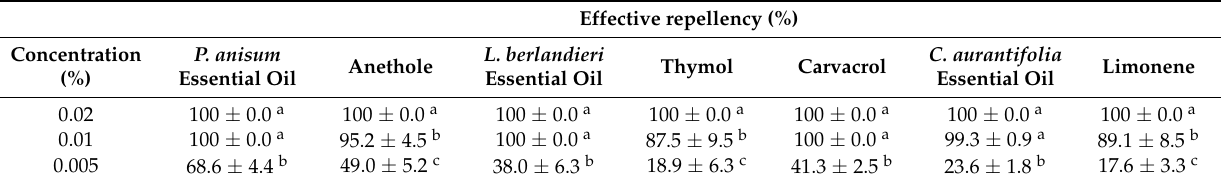
Table 5. Oviposition deterrent activity of P. anisum, L. berlandieri and C.aurantifolia essential oils and their major components against gravid female Culex